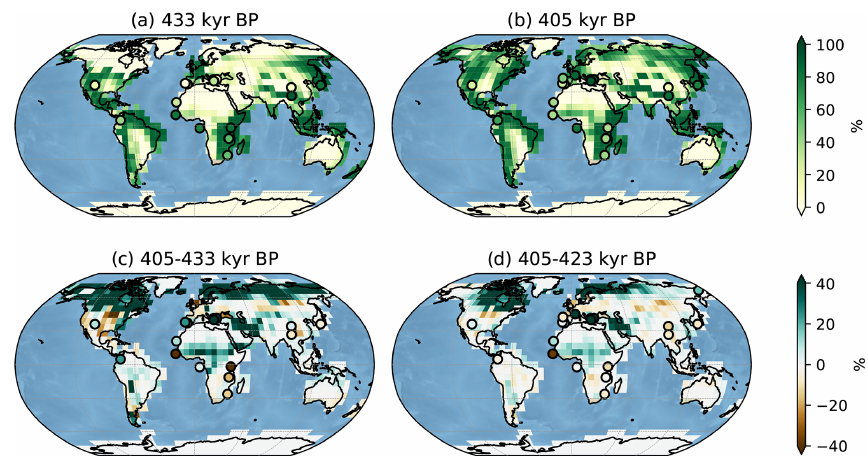
Figure 6. Global comparison of simulated tree fraction (square patches, %) and forest pollen from records (circles, %) at 433kyrBP (a) and at 405kyrBP (b) . Panels (c) and (d) feature the tree fraction difference between 405 and 433kyrBP and 405 and 423kyrBP respectively. Pollen record percentages should be compared to the simulated tree fractions of the closest adjacent